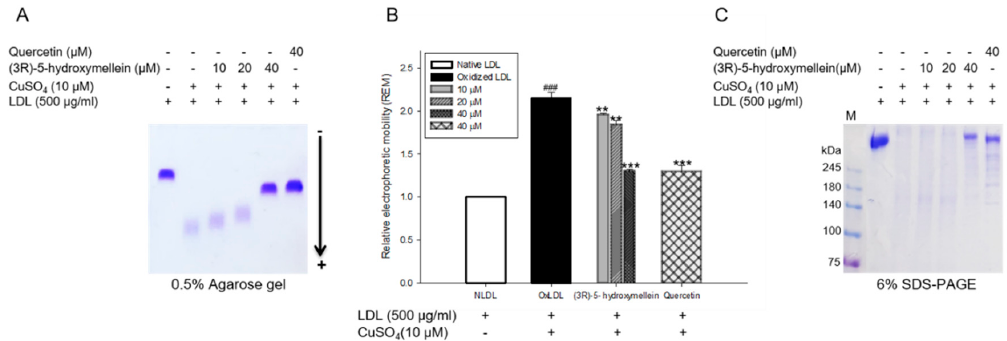
Figure 3. Effect of (3 R )-5-hydroxymellein on conformational changes in oxidized LDL. ( A ) Figure3. Effectof(3 R )-5-hydroxymelleinonconformationalchangesinoxidizedLDL.( A )Electrophoretic mobility profiles of LDL, which were treated with (3 R )-5-hydroxymellein (at 10, 20, and 40 µ M) in the presence of 10 µ M of copper ion. ( B ) The graph shows the calculation of relative electrophoretic mobility, which was calculated as the distance traveled from the origin. ( C ) SDS-PAGE of oxidized LDL by 10 µ M copper ion for 4 hr in the absence or presence of extract (at 10, 20, and 40 µ M). Quercetin used as a positive control. These data are expressed as mean ± SD of three independent experiments. ### p < 0.001 vs. NLDL (native LDL); ** p < 0.01 vs. oxLDL (oxidized LDL); *** p < 0.001 vs. oxLDL (oxidized